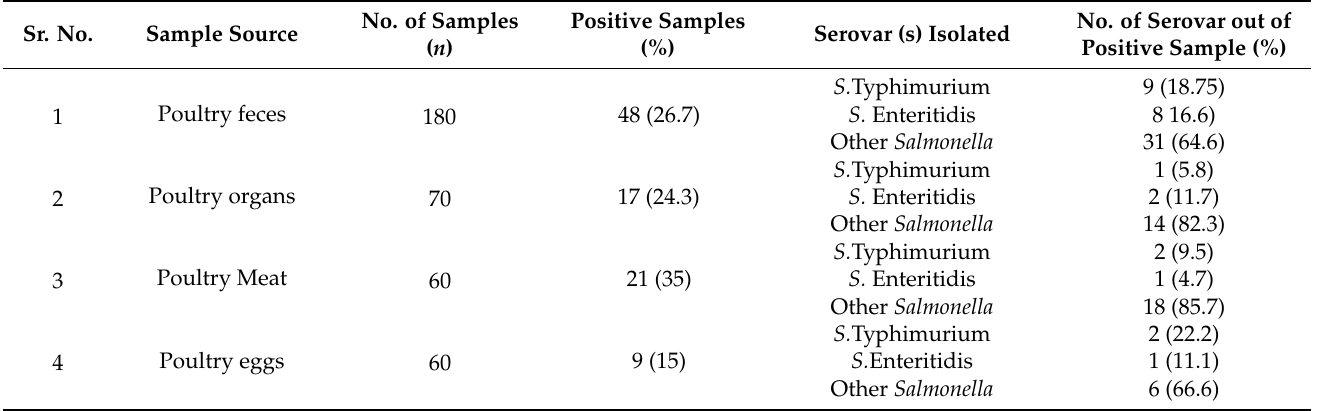
Table 3. Prevalence of Salmonella in poultry feces, poultry organs, and poultry food products. Sr.